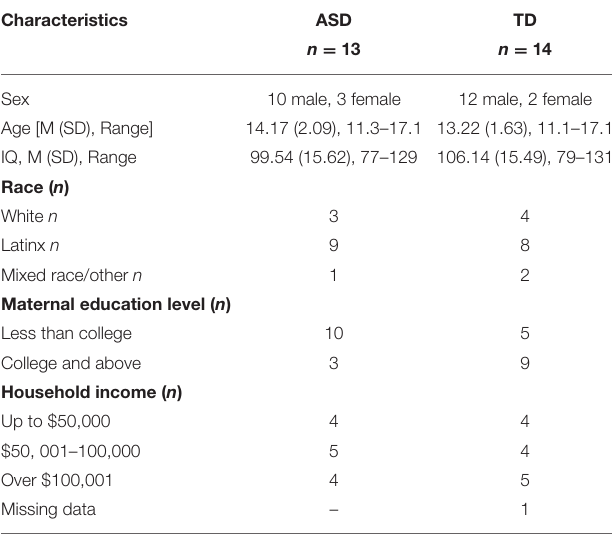
TABLE 1 | Descriptive characteristics of the autism spectrum disorder (ASD) and neurotypical (TD) groups at Time 1. Characteristics ASD